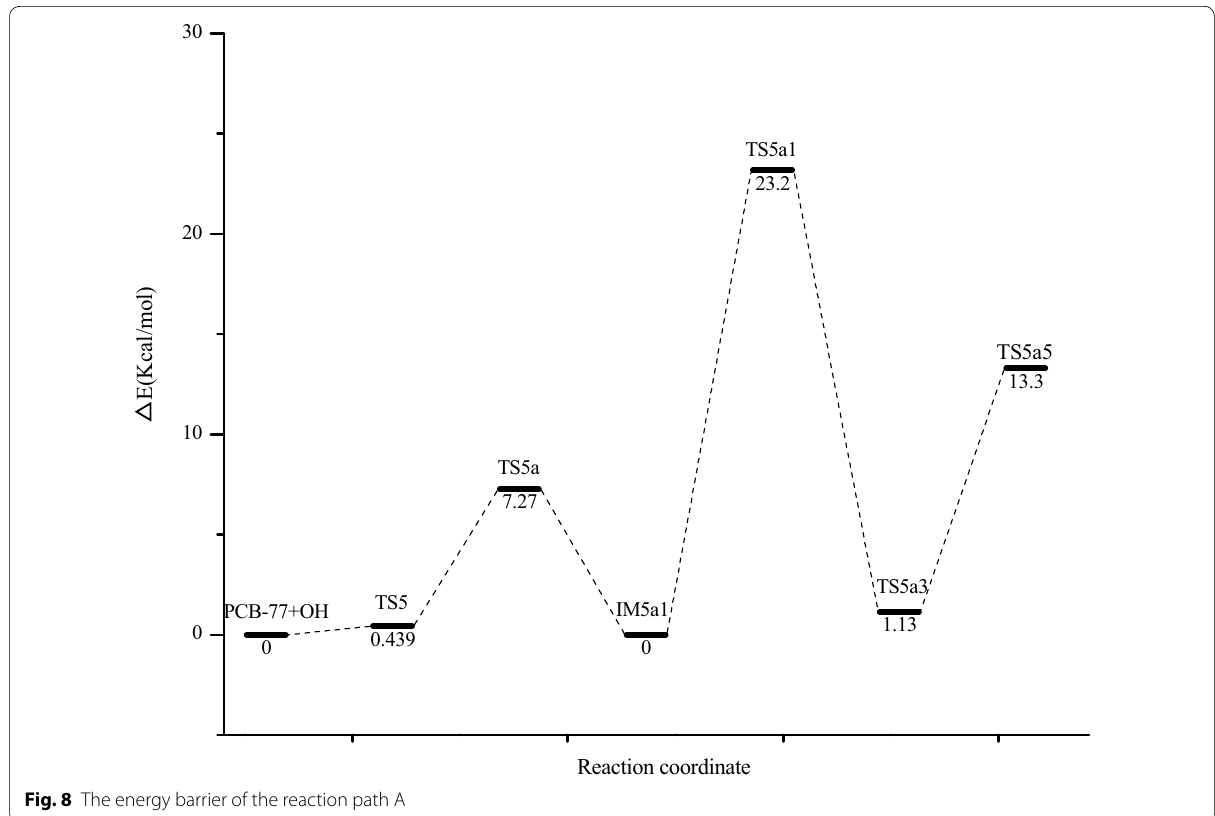
Fig. 8 The energy barrier of the reaction path A